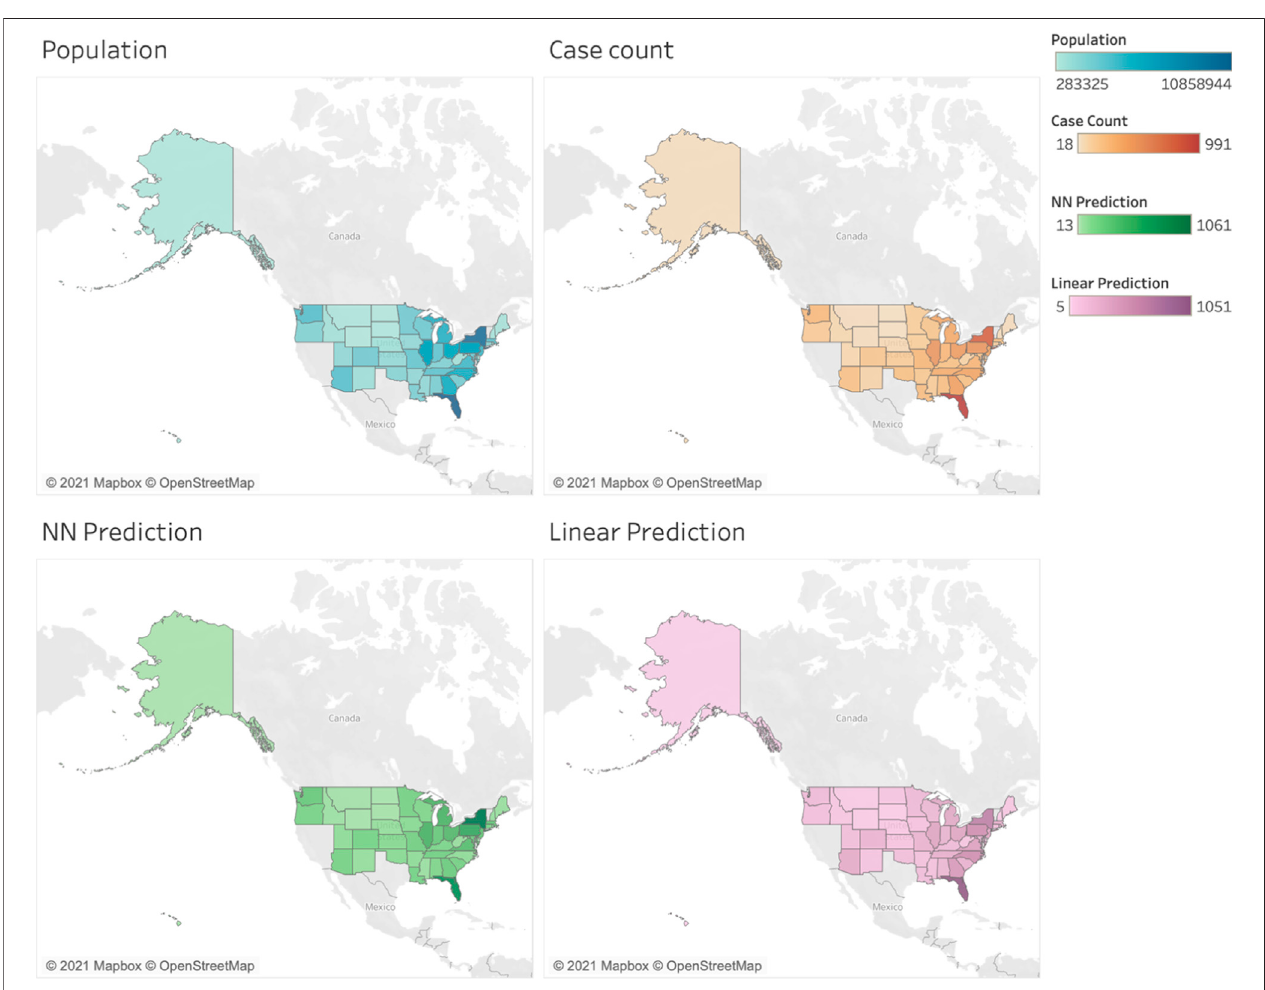
FIGURE 3 | Visualization of the predictive results. The fi rst row shows the population and case count distribution in the US, and the second row shows the predictions of neural network (NN) model and linear model.